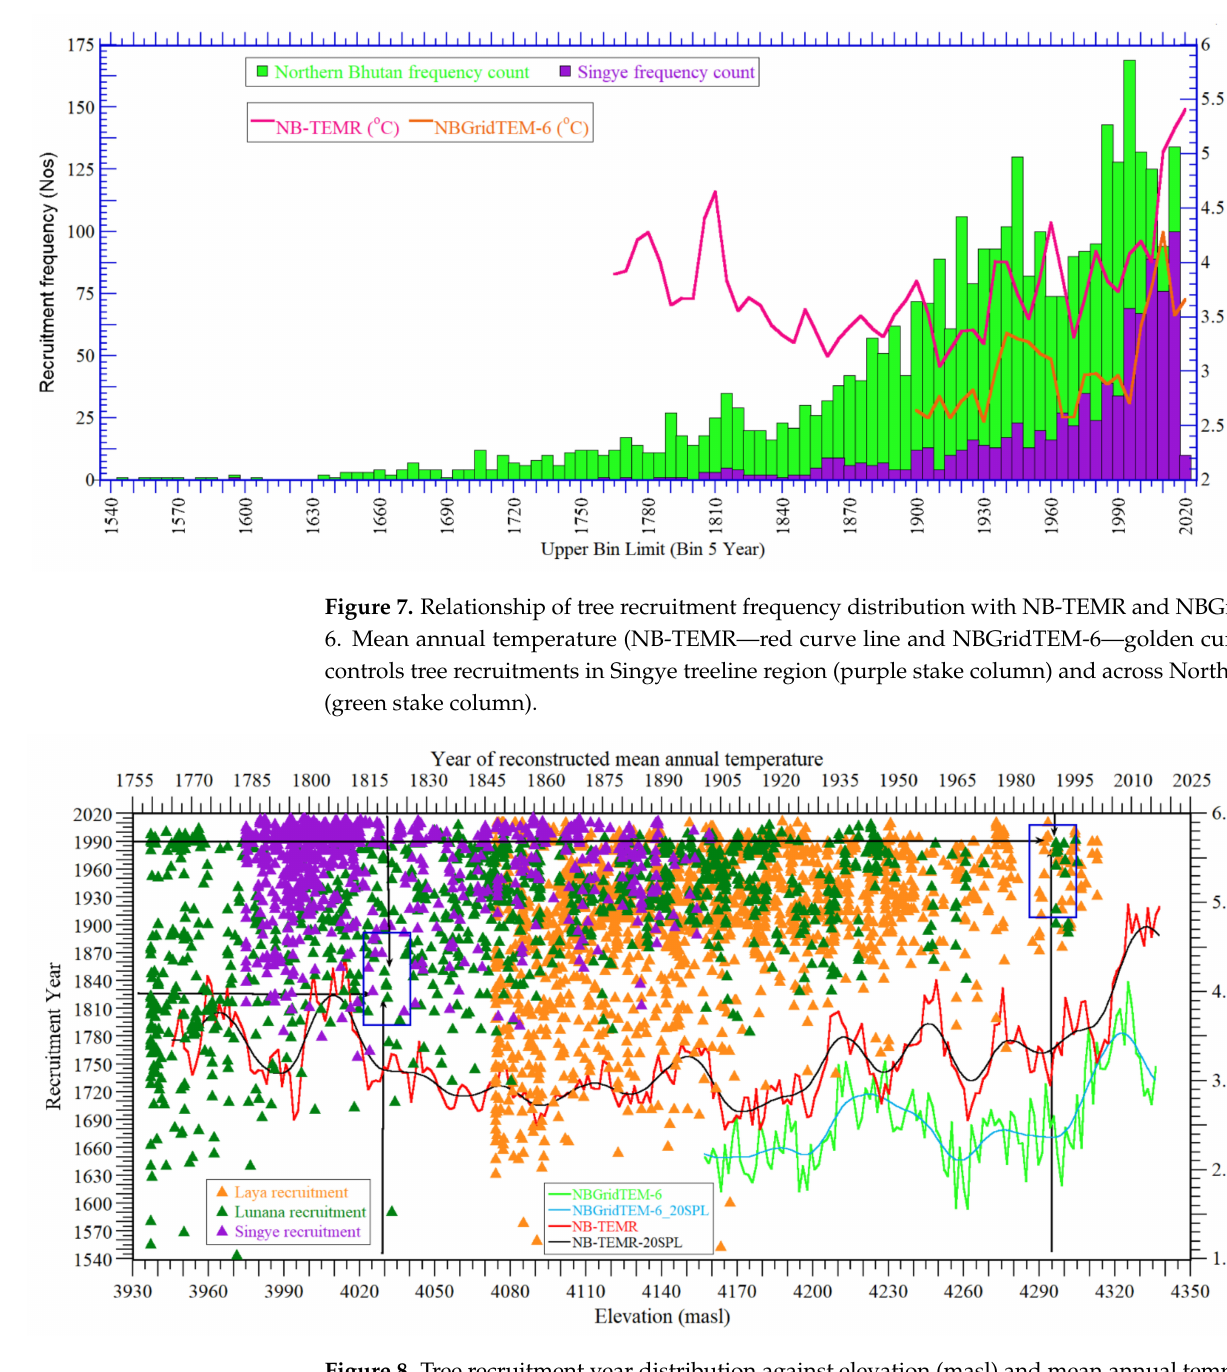
Figure 8. Tree recruitment year distribution against elevation (masl) and mean annual temperature. Green triangle, golden triangle and purple triangle represent tree recruitment year distribution